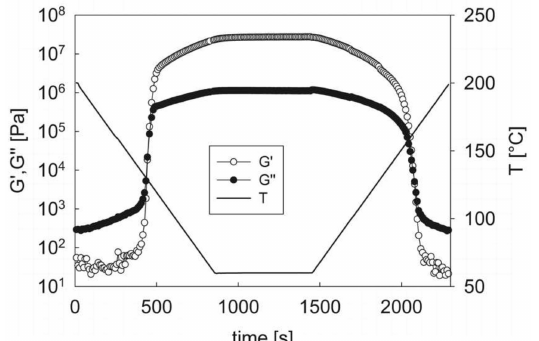
Figure 2. The elastic and loss moduli as a function of time during a cooling/heating ramp at 10 ◦ C/min. The temperature history is reported on the right y -axis. The oscillation frequency is 10 rad/s. The strain is adjusted to guarantee the linear viscoelastic response at all